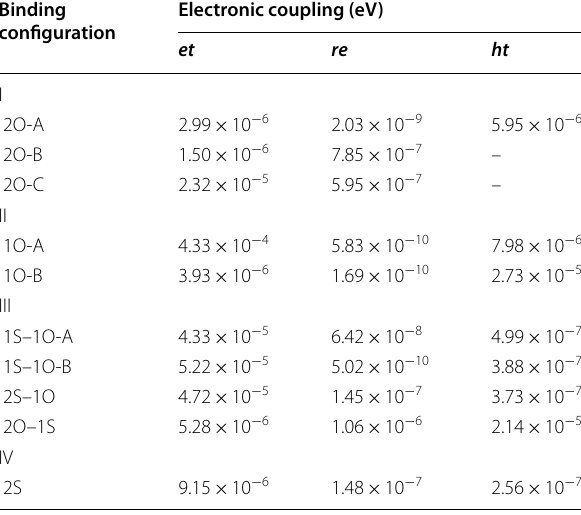
Table 2 Electronic couplings for different charge transfer pathways ( et , ht , and re ), as depicted in Fig. 1 Binding